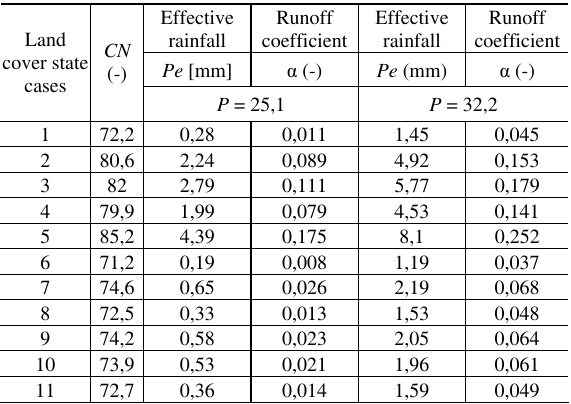
Table 5 . Simulated values of effective rainfall for specified land cover cases of Trojanka catchment and selected (empirical) rainfall events